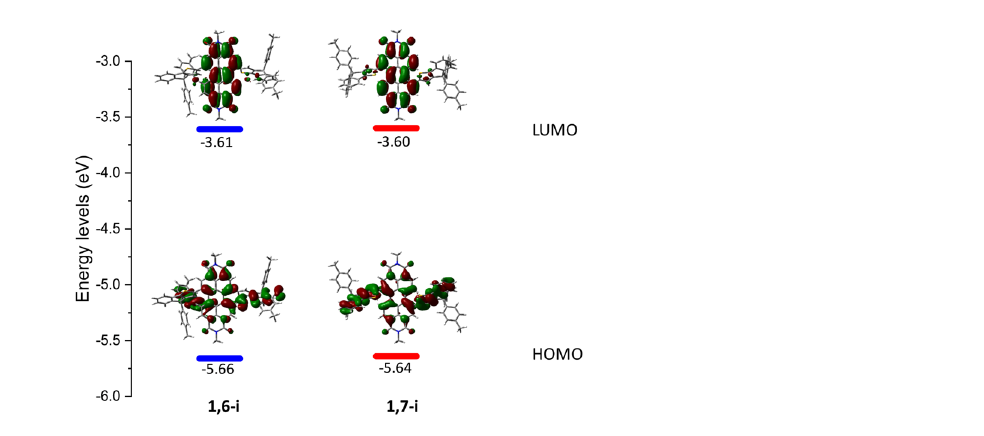
Figure 6. HOMO and LUMO electron density and energy levels calculated by DFT for 1,6-i and 1,7-i .